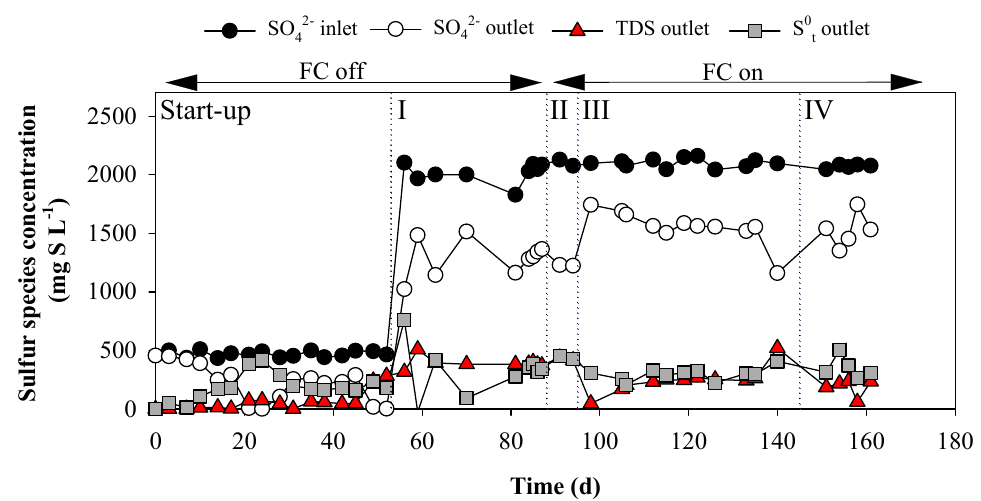
Figure 3. Evolution of sulfur species concentration along the BES-FC operation phases, sulfate in the inlet and outlet, total dissolved sulfide (TDS) in the outlet and theoretical elemental sulfur produced (T-S 0 ) in the outlet. N.B. the lack of statistically significant discrepancy between TDS and S 0 at the outlet indicate that there is no formation of intermediate sulfur products, as previously shown by Pozo et al. [30].